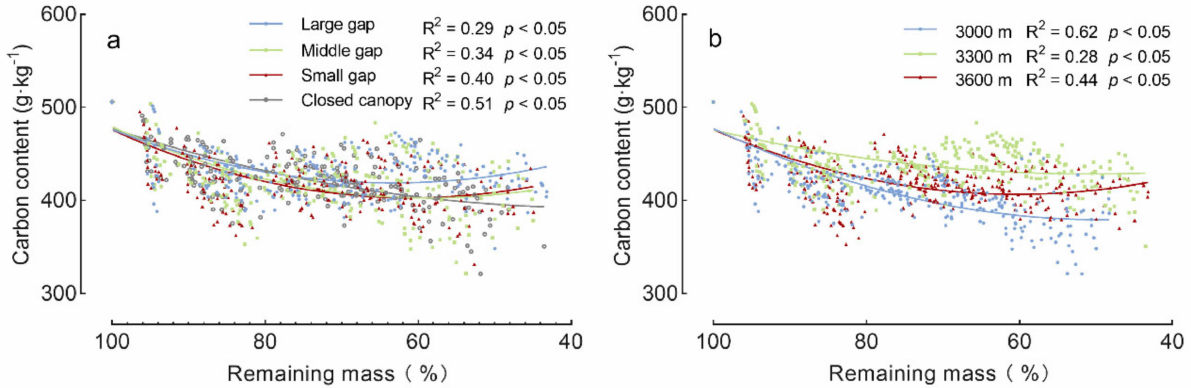
Figure 4. Carbon content versus remaining mass in decomposing A. faxoniana litter. ( a ) Forest gap scale; ( b ) Elevation scale. R 2 and p values from linear regression are shown in each